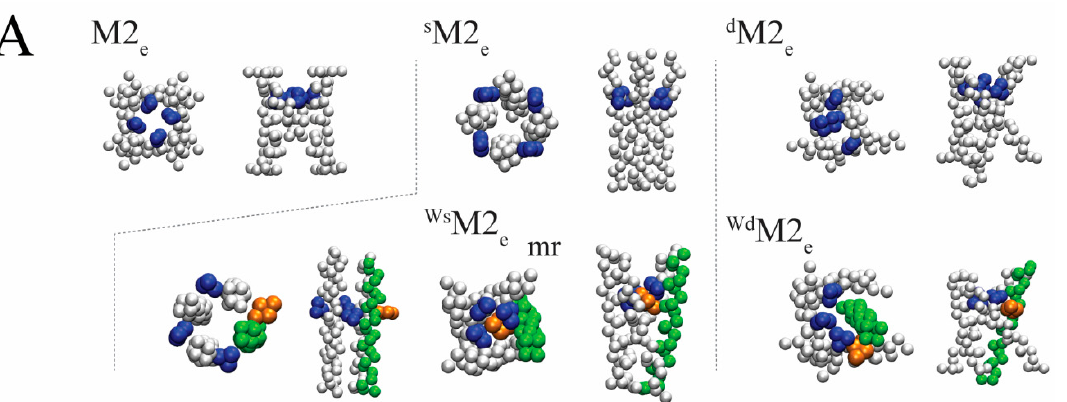
Figure 4. Assembled structures of CG bundles of M2, E TMDs, and with a helical poly-peptide (pp). ( A ) First ranked (1r) tetrameric structures of M2 e , s M2 e and d M2 e in a top (left, upper row) and side view (right, upper row) and when assembled with poly-peptide (pp) tryptophan (W), Ws M2 e and Wd M2 e , in its C α form for which the C α atoms adopt the same coordinates as the experimental struc- tures (C α p-peptide) (lower row). ( B ) Pentameric 1r structures of E t , redocked structures s E t and d E t (upper row) and as Ws E t and Wd E t (lower row). All bundles are shown in a top view (left side) and side view (right side). “mr” marks the structure with the marker-residues (mr’s) facing the putative pore. Blue spheres mark the mr’s H37 for M2 and F26 for E. The C α p-peptide with tryptophan, pp- W, is shown in green with one W highlighted in orange to indicate the rotational orientation of the pp-W. All other representative models of the amino acids are shown in grey spheres. Changing the reference points to those which are obtained by using the redocked reference structures independent of the screening protocol, leaves solely the groups KRH and FYW having improved EBEs (Supplementary Tables S2 and S3, green tiles). The re- sults are indifferent to the type of screening protocol used. Based on the different docking protocols used and the simplified representation of the ligand by pp’s, it is revealed that KRH and FYW show the best result. 4. Discussion 4.1. Consideration on the Set-Up of the System Ideal helices are chosen for the case that no experimental structure is available and they stand for easy-to-access models of TMDs. The use of POPCs as the lipids in the hy- drated lipid bilayer system generating the AA-MD models is due to the findings that POPCs are the most abundant lipids in the cellular membranes [71], thus representing a reliable model system. The docking approach is referred to as ‘almost 2D’ docking. This